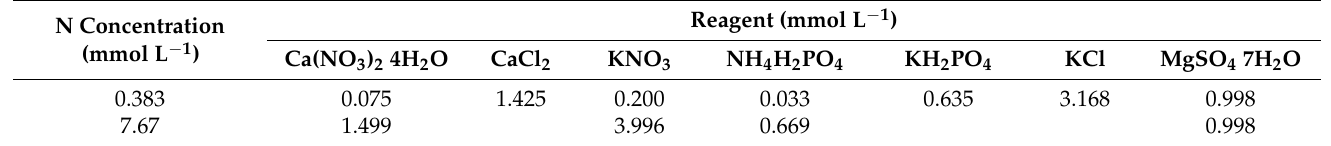
Table A1. N nutrient solution formula with different